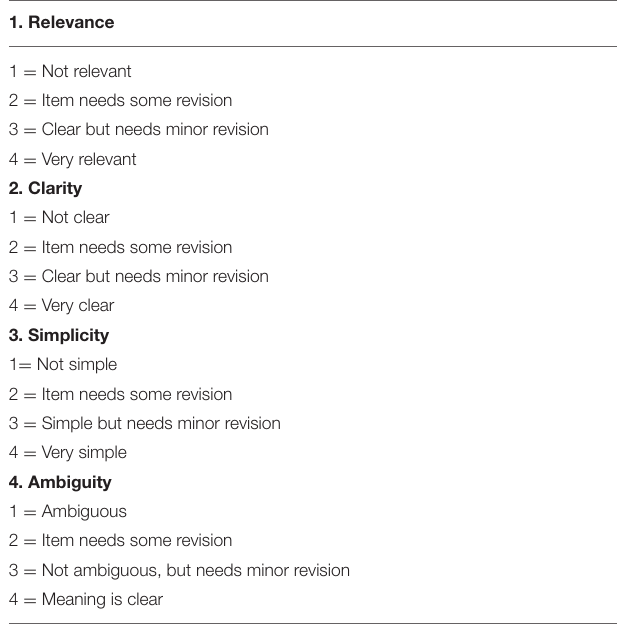
TABLE 4 | Criteria for measuring content validity (Waltz and Bausell,